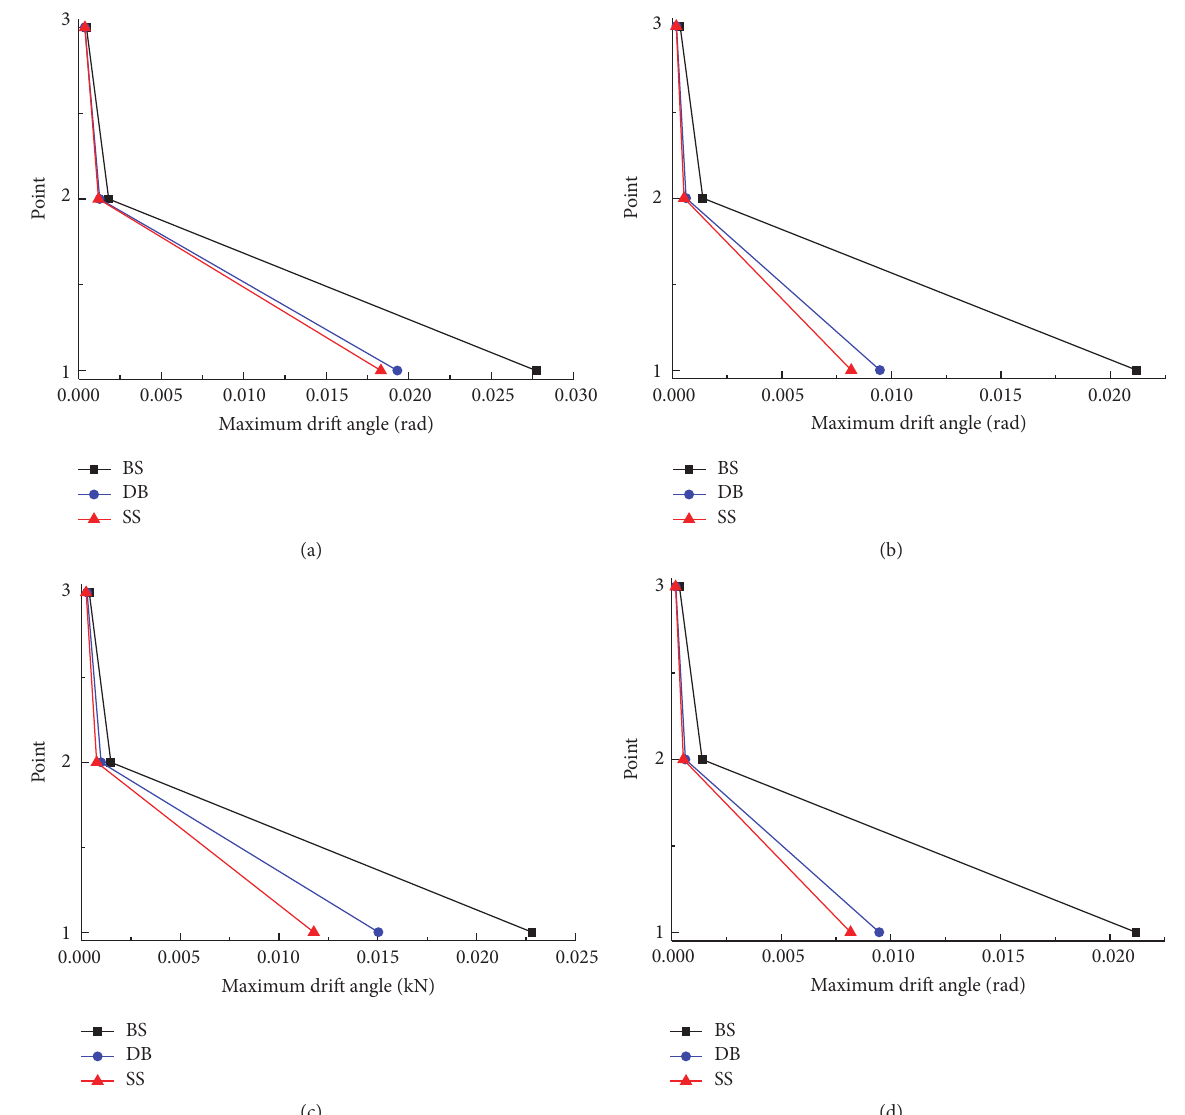
Figure 17: Maximum drift angle distribution for PGA = 0.62 g: (a) El Centro NS, (b) Taft EW, (c) Northridge EW, and (d) Kobe